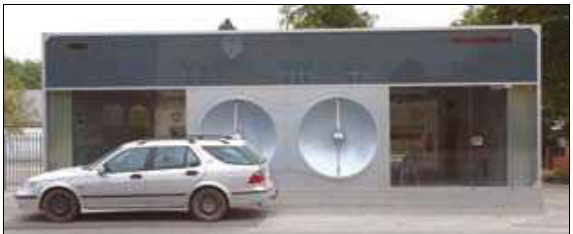
Fig. 10. “Lelija“ shop in Vilniu­s. a­r­chitects s­. ku­ncevičiu­s,